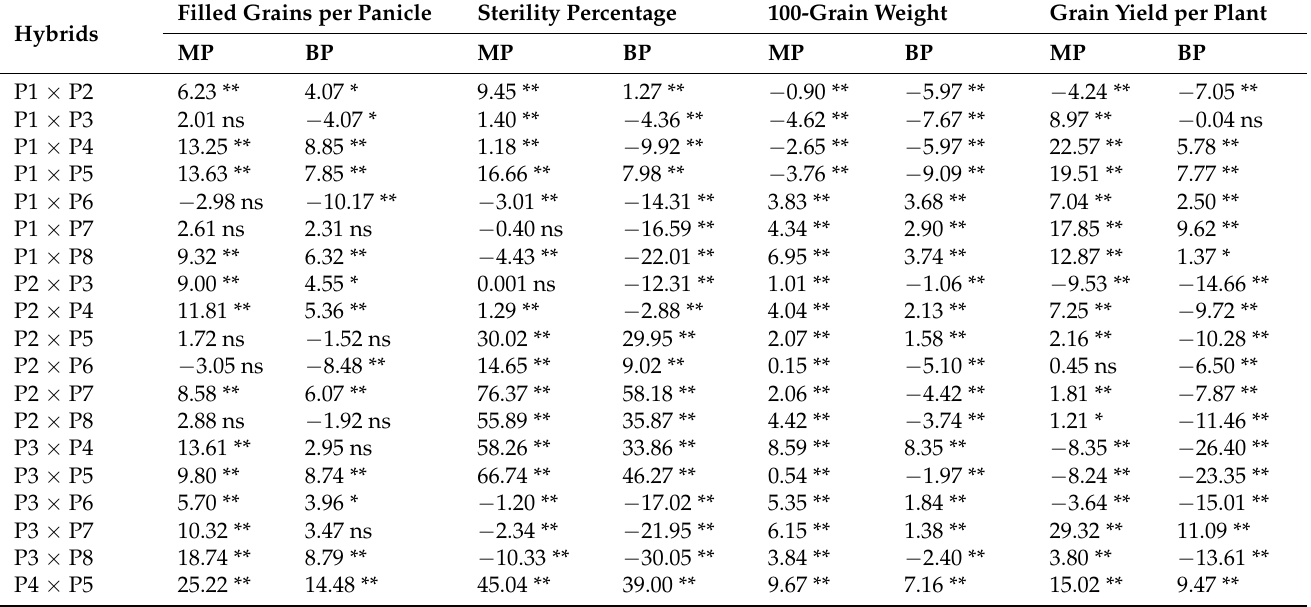
Table 3. Mid-parent heterosis (MPH) and better-parent heterosis (BPH) for 28 F 1 hybrids from half-diallel analysis of grain yield and its components’ traits under drought